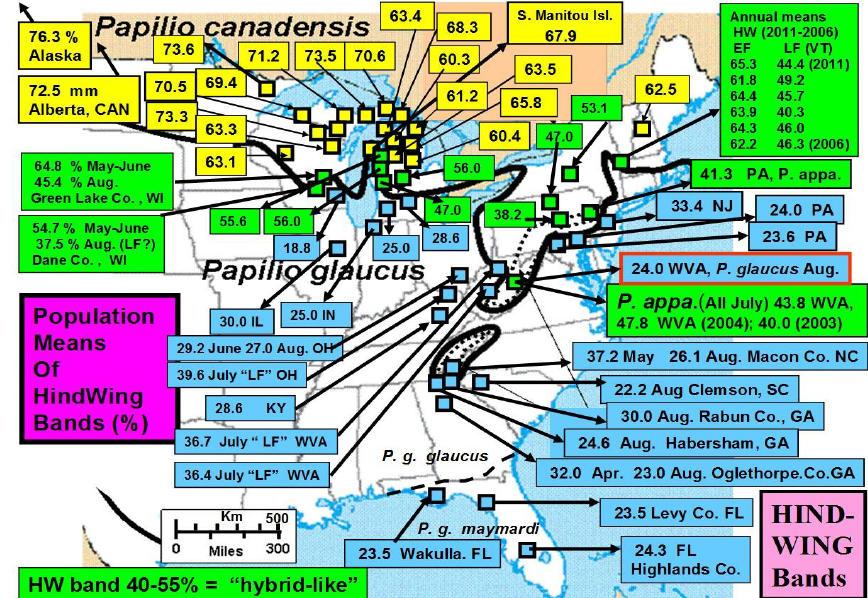
Figure 13. The mean annual male hindwing band widths of selected Papilio populations of P . glaucus (blue, 10% (cid:177) 44%), P . canadensis (yellow, 40% (cid:177) 55%), and their hybrids (green, 40% (cid:177) 55%, showing the historical hybrid zone (dark line), which basically has been delineated by the 2,600 Degree-days on the thermal landscape (see Figures 2 and 3). The putatively univoltine P . appalachiensis (the hybrid species) is indicated in West Virginia (Pendleton Co., West Virginia, USA) as is the second generation males of P . glaucus (found just 1,000 m lower in elevation below Spruce Knob, where more D-days accumulate annually) flying in August, 2 (cid:177) 4 weeks later. Mean HW bands of the Vermont (cid:85)(cid:72)(cid:70)(cid:82)(cid:80)(cid:69)(cid:76)(cid:81)(cid:68)(cid:81)(cid:87)(cid:3)(cid:75)(cid:92)(cid:69)(cid:85)(cid:76)(cid:71)(cid:86)(cid:3)(cid:179)(cid:47)(cid:41)(cid:180)(cid:3)(cid:68)(cid:81)(cid:71)(cid:3)(cid:87)(cid:75)(cid:72)(cid:3)(cid:72)(cid:68)(cid:85)(cid:79)(cid:92)(cid:3)(cid:73)(cid:79)(cid:76)(cid:74)(cid:75)(cid:87)(cid:3)(cid:68)(cid:87)(cid:3)(cid:87)(cid:75)(cid:76)(cid:86)(cid:3)(cid:86)(cid:76)(cid:87)(cid:72)(cid:3)(cid:68)(cid:85)(cid:72)(cid:3)(cid:76)(cid:81)(cid:71)(cid:76)(cid:70)(cid:68)(cid:87)(cid:72)(cid:71)(cid:3)(cid:73)(cid:82)(cid:85)(cid:3)(cid:87)(cid:75)(cid:72)(cid:3)(cid:21)(cid:19)(cid:19)(cid:25)(cid:177) 2011 years (see also Table